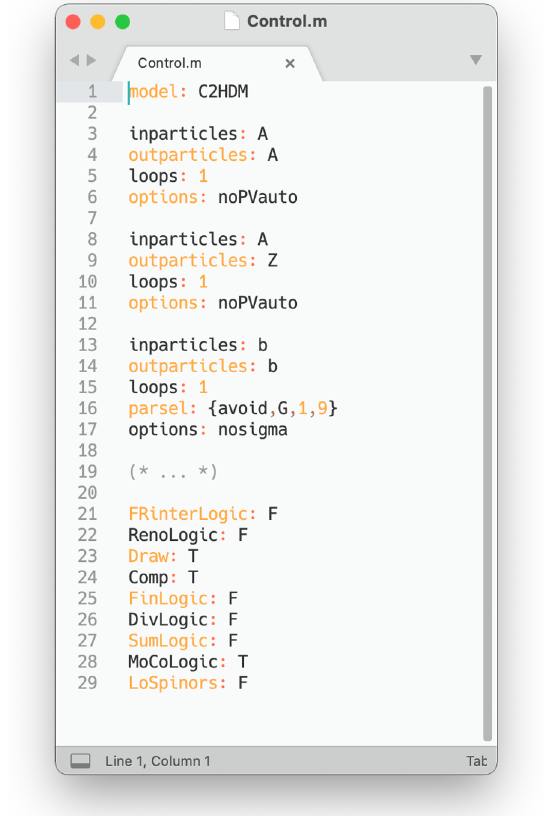
Figure 11 . Sketch of the Control.m file used to generate all the one-loop GFs required to renor- malize the model. See text for